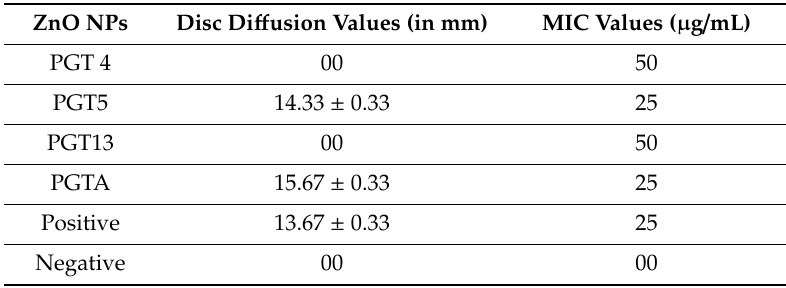
Table 7. Evaluation of the bactericidal activity of biosynthesized zinc oxide nanoparticles from di ff erent species of Trichoderma against di ff erent strains of Xanthomonas oryzae pv. oryzae (Xoo) (Concentration expressed in µ g /